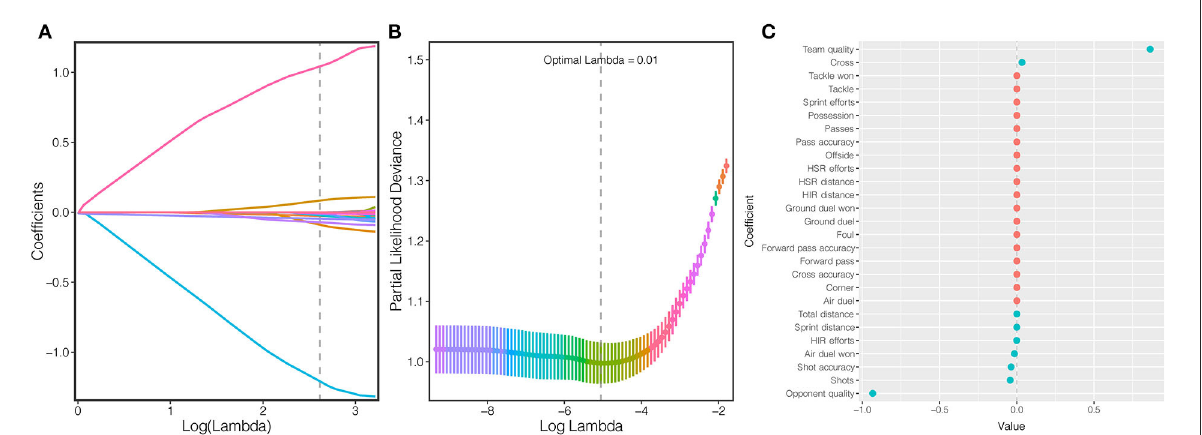
FIGURE1 Feature selection using the least absolute shrinkage and selection operator (LASSO) binary logistic regression model. (A) LASSO coefficient profiles for key features, each coefficient profile plot is produced vs. log( λ ) sequence. The dotted vertical line is set at the nonzero coefficients selected via a 10-fold cross-validation, where nine nonzero coefficients are included. (B) By verifying the optimal parameter (lambda) in the LASSO model, the partial likelihood deviance (binomial deviance) curve is plotted vs. log( λ ). At the log ( λ ) of the optimal values, where features are selected, dotted vertical lines are set using the minimum criteria and the one standard error of the minimum criteria. (C) The specific coefficient of each variable is presented by (LASSO) binary logistic regression. The red dot means the variable is excluded while the green dot means the variable is selected in the following